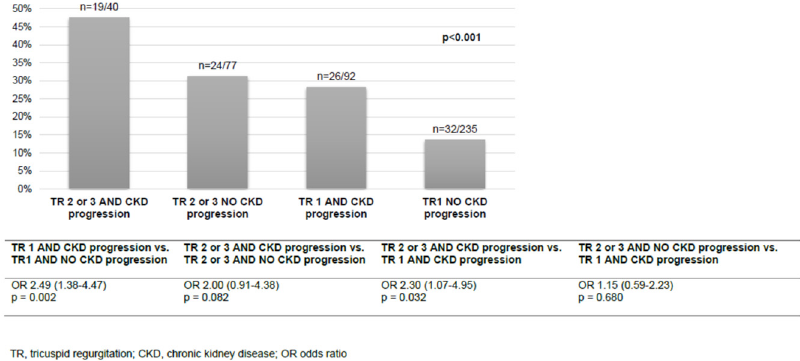
Figure 2. All-cause mortality according to the grade of TR and CKD